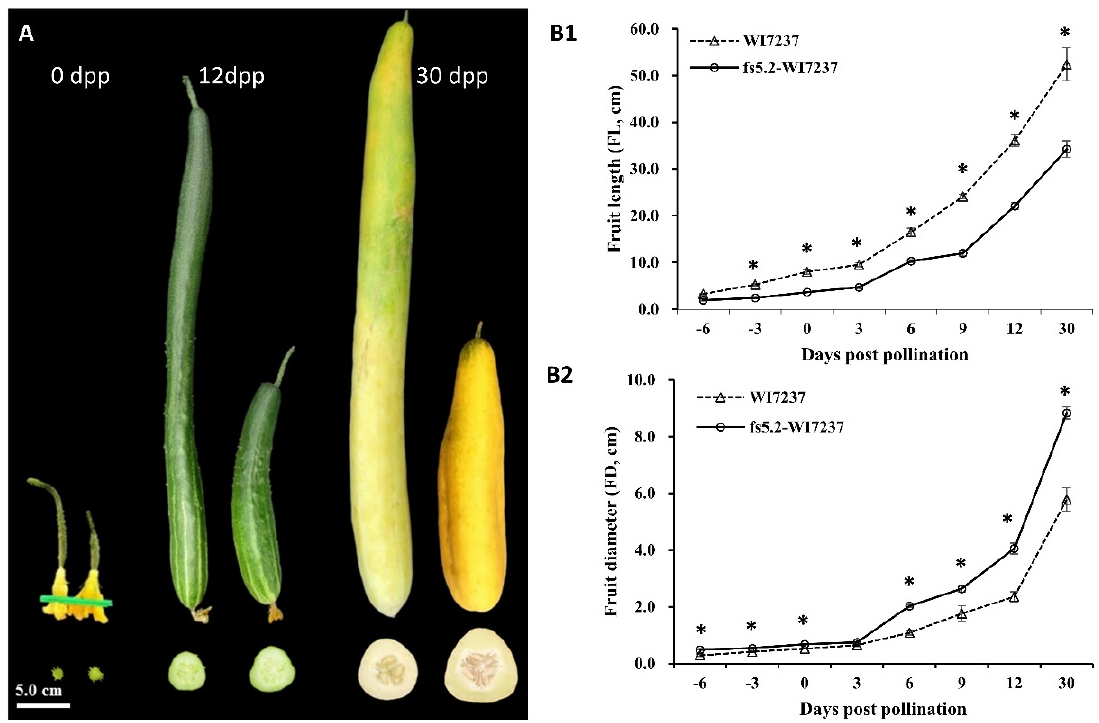
Figure 2. Fruit growth at different development stages of fs5.2 NILs. ( A ) Appearances of ovaries, immature fruits, and mature fruits of WI7237 ( left ) and fs5.2-WI7237 ( right ) at anthesis day (0 day post pollination, dpp), 12, and 30 dpp. ( B1 , B2 ) Fruit length and diameter at different days of pollination in the NILs. Error bar for each data point represents the mean ± SD (standard derivation) from three replications. At each timepoint, WI7237 fruit is significantly longer but slimmer than that of fs5.2-WI7237 (* p < 0.05 based on t test).